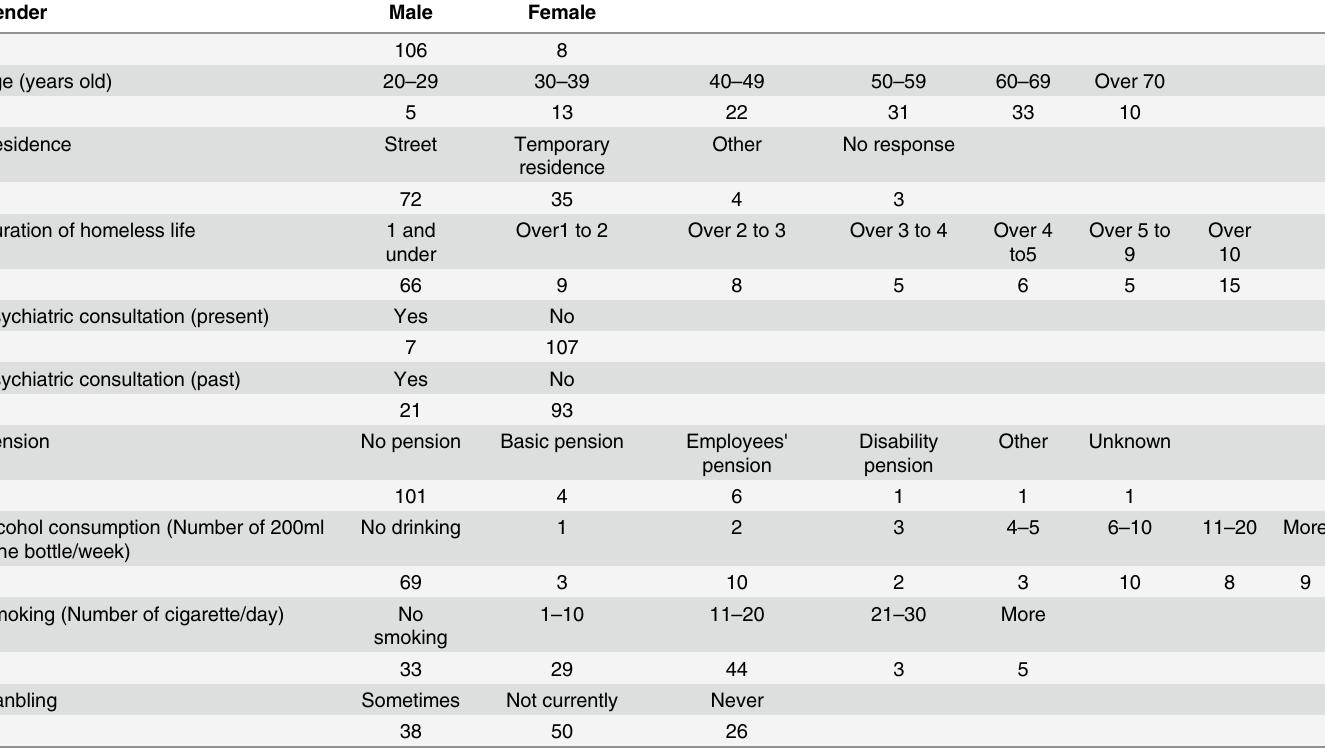
Table 1. Participant demographic